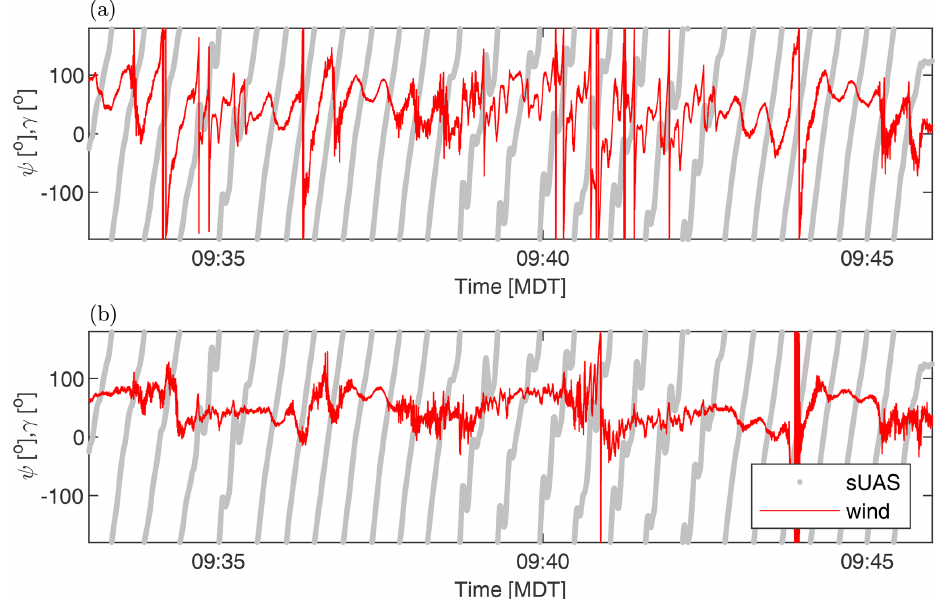
Figure 5. Comparison between measured wind direction and aircraft yaw direction for (a) uncorrected and (b) corrected signals as a function of time for a single